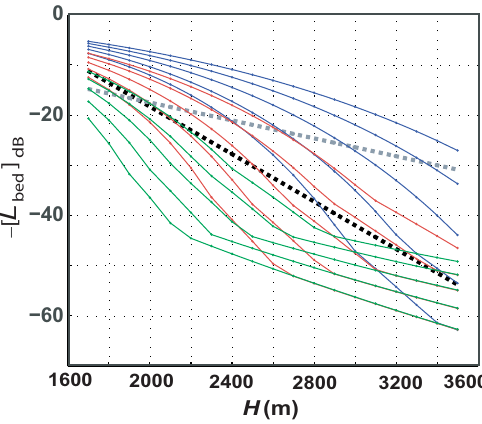
Fig. 8. Ice-thickness variations of power loss caused by two-way attenuation, which is estimated by - < N > H . < N > is the depth- averaged attenuation rate (see Supplement Sect. C). Green, red, and blue curves show cases for geothermal fluxes of 40, 50, and 60mWm − 2 , respectively. For each geothermal flux, five curves show the cases for surface mass balance (ice equivalent) of 20mm yr − 1 (bottom), 30mm yr − 1 , 40mm yr − 1 , 50mm yr − 1 , and 60mm yr − 1 (top). The gray dotted line shows the power loss estimated with the ensemble-mean attenuation rate derived using model esti- mates for ice thicknesses less than 2400m. The black dotted line shows the power loss estimated with the attenuation rate derived with the linear least-square method applied to the modelled results for an ice thickness less than